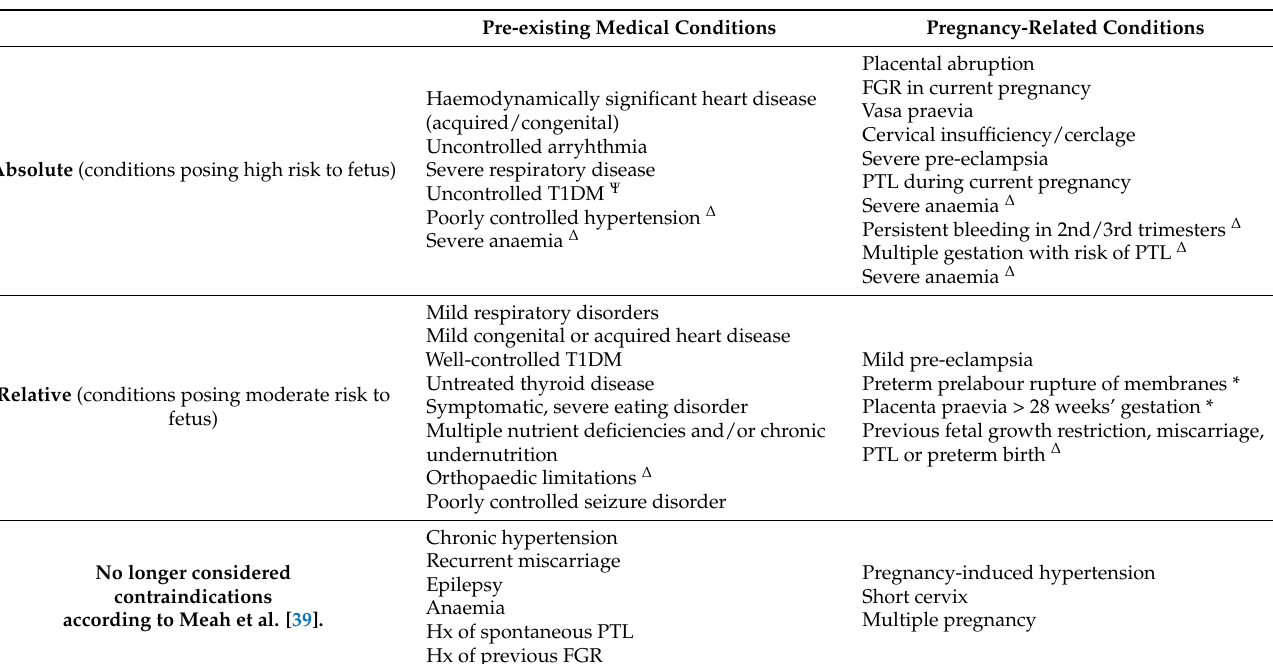
Table 2. Contraindications to aerobic exercise during pregnancy [39,83] : IOC; International Olympic Committee, FGR; intrauterine growth restriction, PTL; preterm labour, T1DM; type 1 diabetes